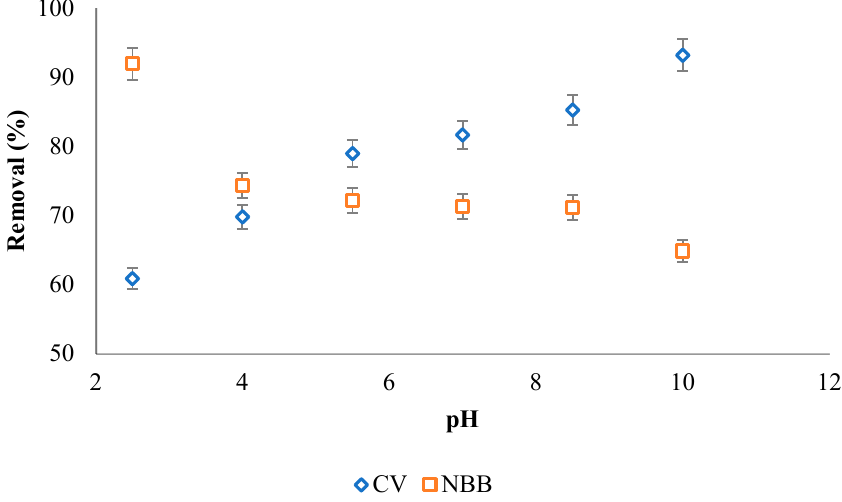
Figure 9. The effect of pH on 100 mg g − 1 NBB and CV removal efficiency by ACOC (T = 25 °C, V = 100 mL, m ACOC is 0.050 g for NBB and 0.020 g for CV).